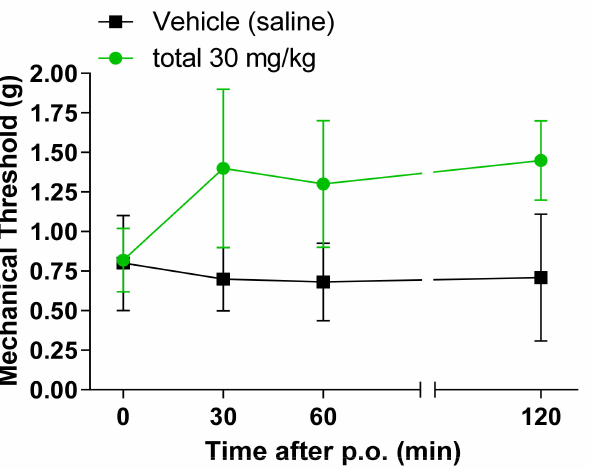
Figure 4. Effect of Symplocos chinensis f. pilosa Ohwi water extract in the Chronic Constriction Injury (CCI) von Frey test in mice. Data are expressed as mean ± SD; n = 4 mice per group.